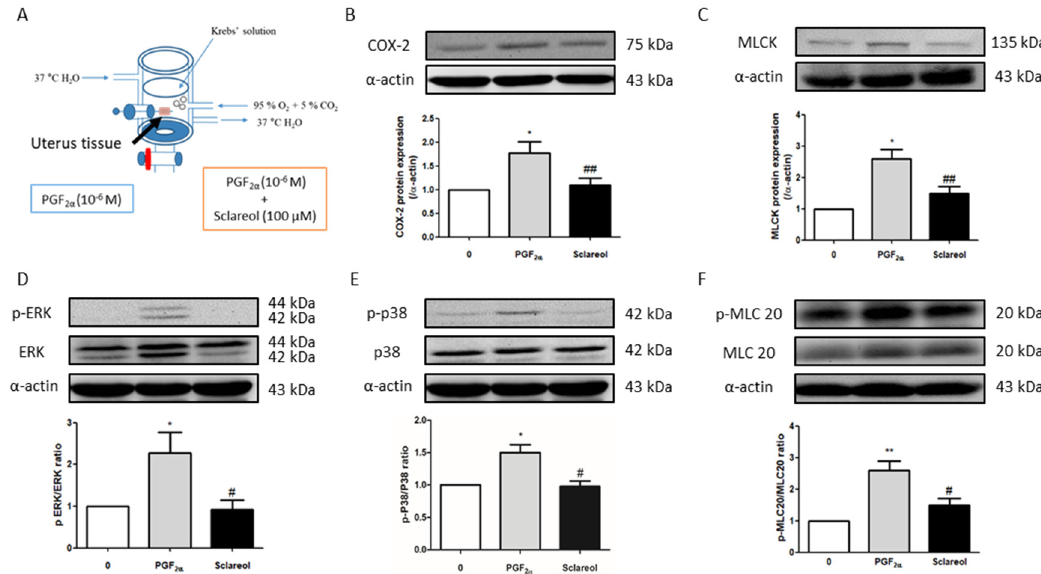
Figure 5. Possible mechanism underlying the effect of sclareol on PGF 2 α -induced uterine